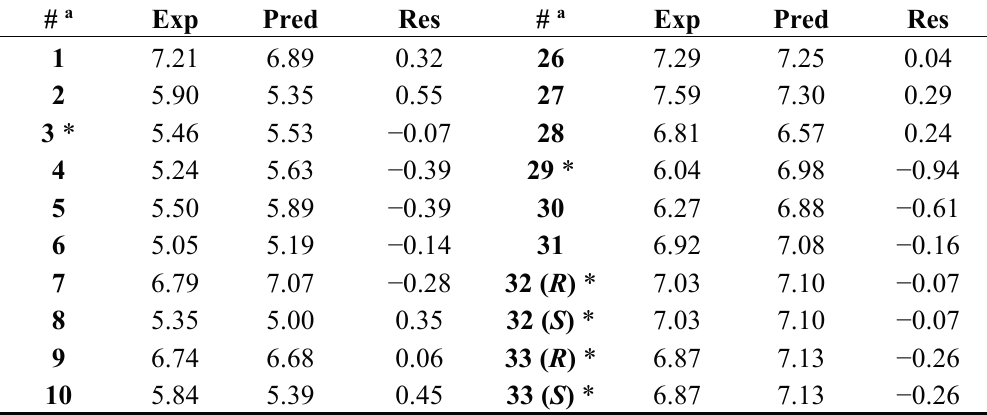
Table 6. Experimental pIC 50 (Exp) and predicted pIC 50 (Pred) biological activities, and residuals (Res = Exp − Pred) of the 6-arylquinazolin-4-amine derivatives using the best HQSAR model with the fragment distinction parameters A/B